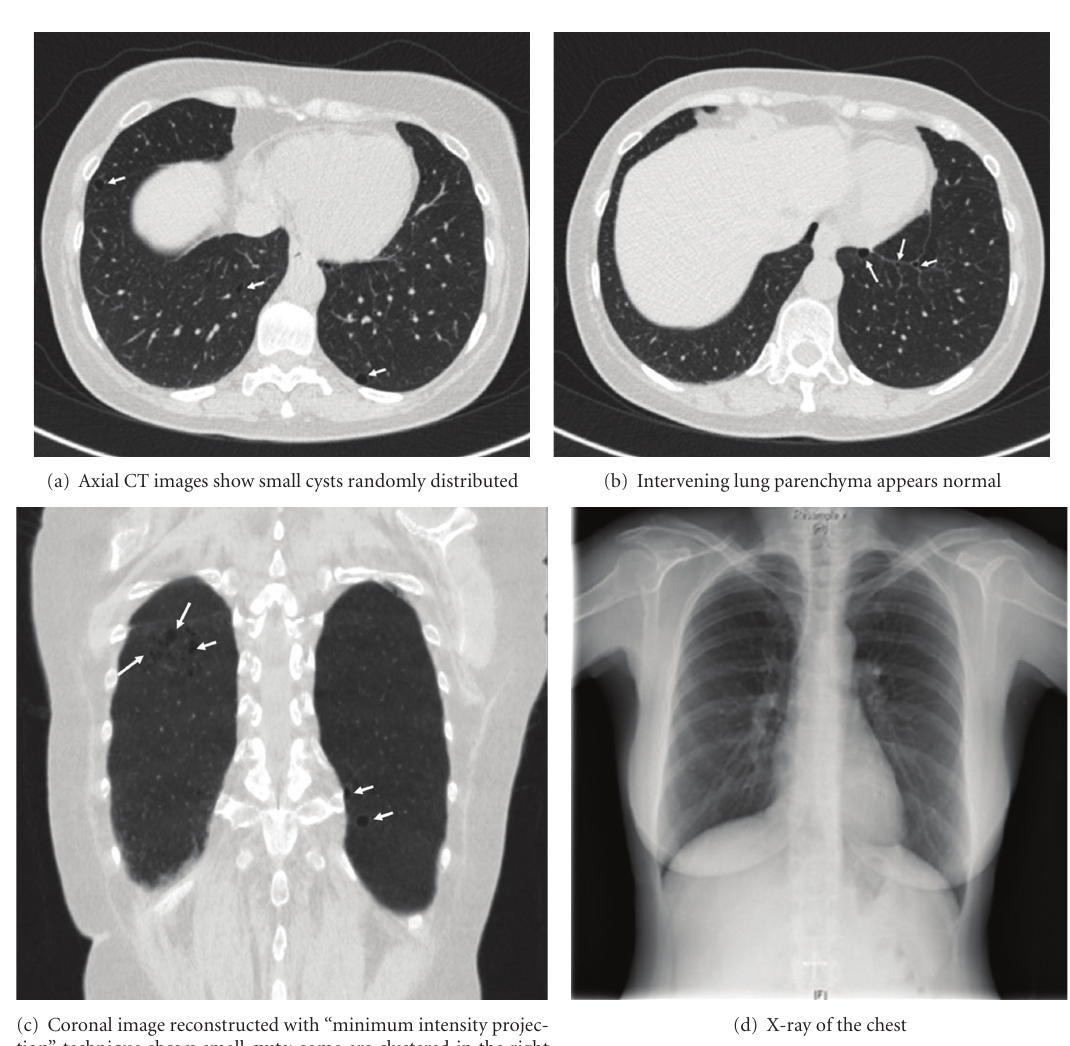
Figure 2: Preoperative CT scan of the thorax (a–c) and chest X-ray